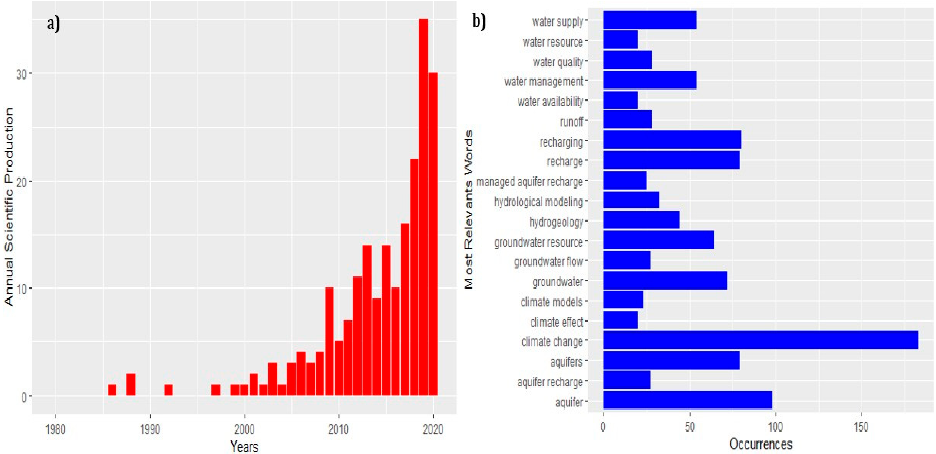
Figure 2. ( a ) Growth in total publications in Scopus collection and Google Scholar from 1980 to 2000. ( b ) Occurrences of most relevant words used in this field between 1980 and 2020.